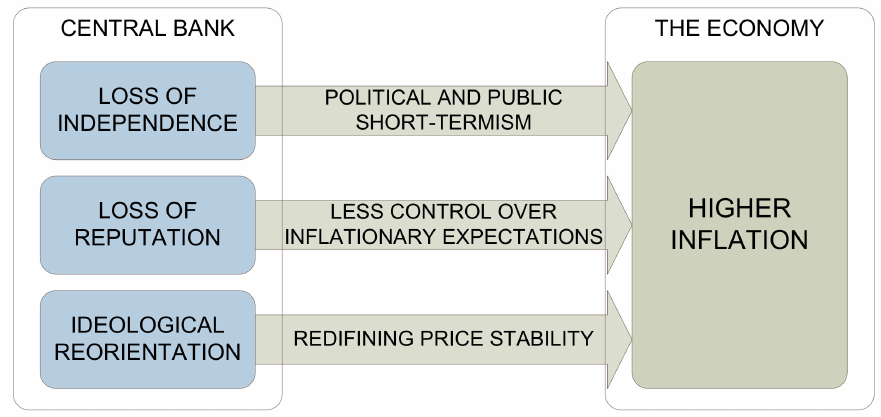
Figure 1. The inflationary consequences of green central